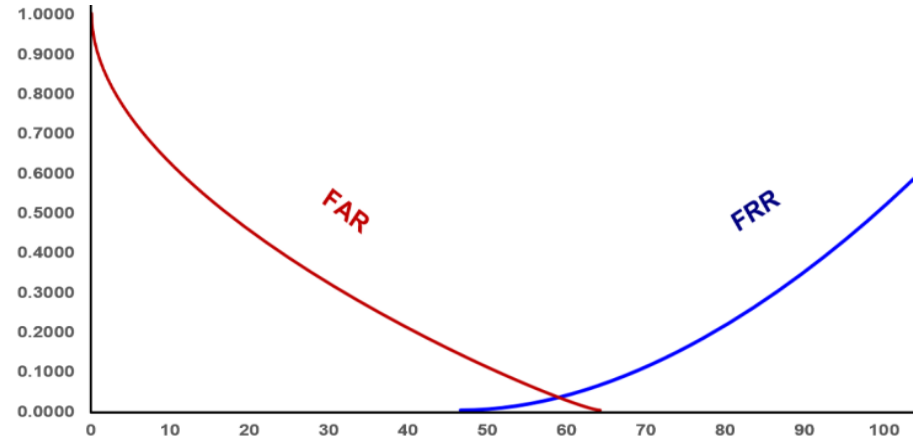
Figure 8. This figure displays the ERR at the intersection of FAR and FRR. The X-axis represents the similarity threshold, and the Y-axis represents error. In this case, at the similarity threshold of 54, the resultant ERR is 0.06.